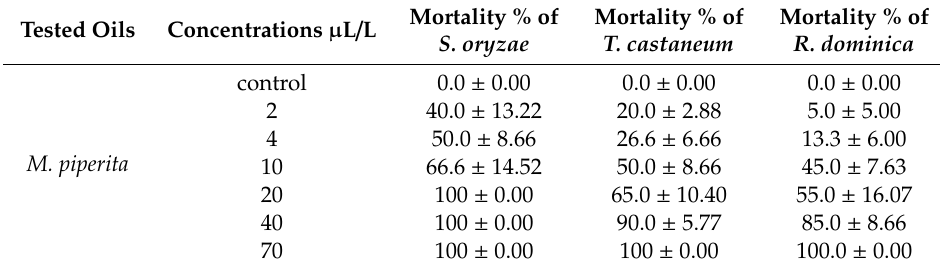
Table 7. Mortality percentage and toxicities of S. oryzae, T. castaneum , and R. dominica treated